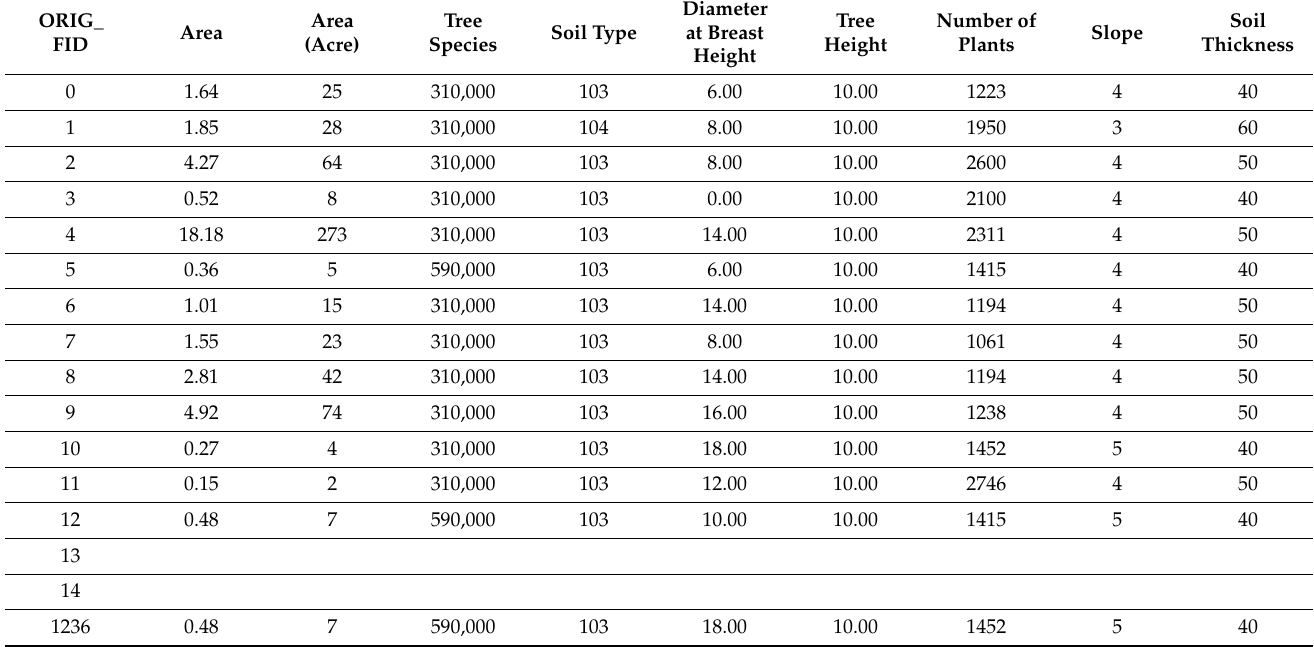
Table 1. Summary table of the fieldwork data.